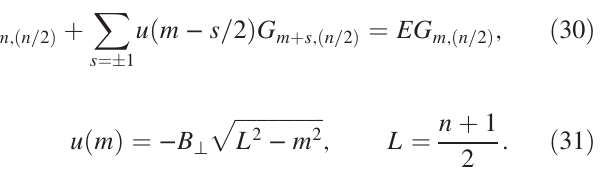
FIG. 3. The black line shows the plot of 2 u ð m Þ (31) vs m between the interval boundaries (cid:3) m ¼ L ¼ ð n þ 1 Þ = 2 . The horizontal dashed-dotted blue line depicts the region of oscil- E Þ with m for a given E described by latory behavior of G m;n= 2 ð the WKB solution (33) [see also Eq. (B5) in Appendix B] and shown in Fig. 4. The boundaries of this region are the turning points m ¼ (cid:3) m 0 ð E Þ given by Eq. (32) and depicted with blue dots. The regions of m ∈ ½ m 0 ð E Þ ; L (cid:2) ∪ ½ − L; − m 0 ð E Þ(cid:2) corre- E Þ with m (or spond to the exponential growth of G m;n= 2 ð decrease with d ¼ n= 2 − m ). The WKB solution for the right region is given in Eq.